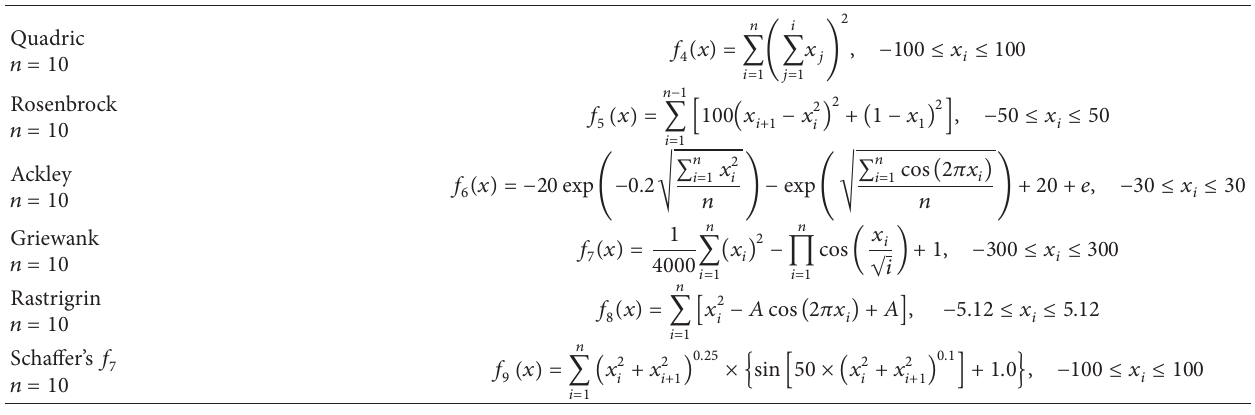
Table 1: High dimensional